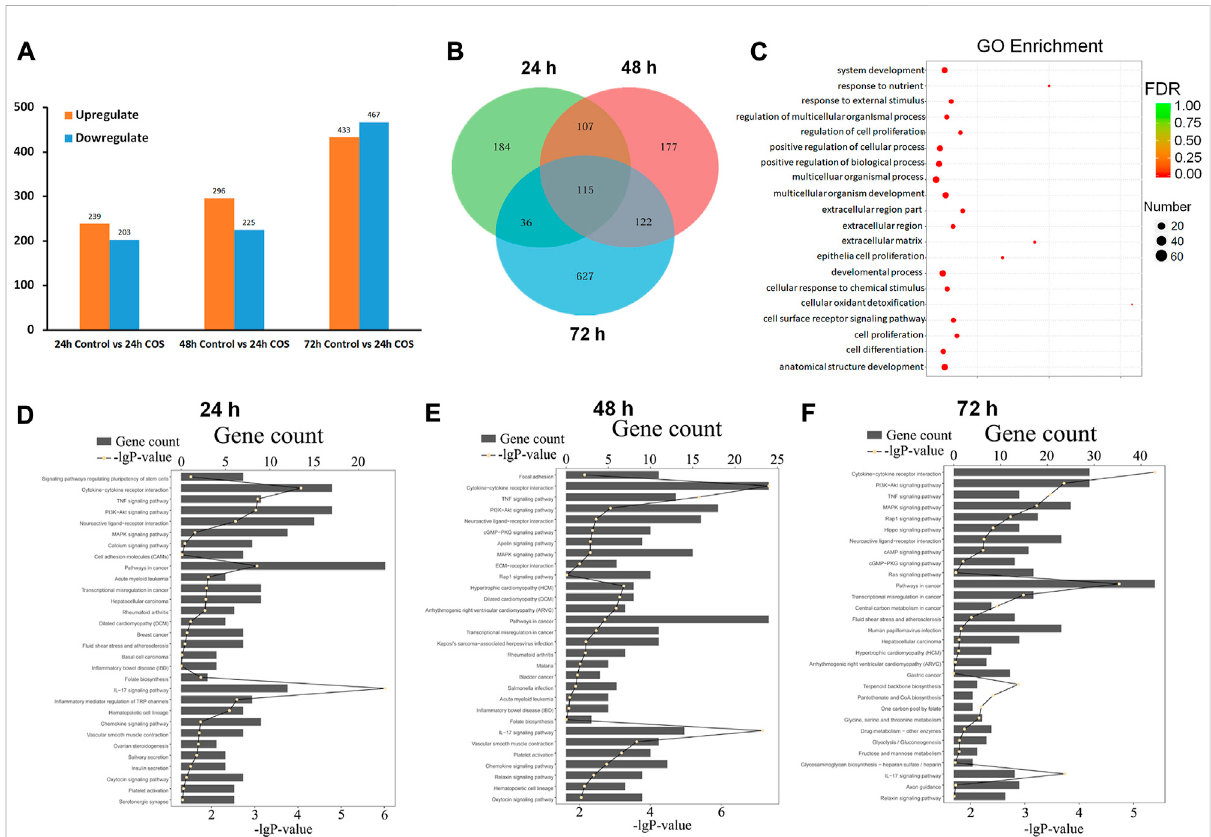
FIGURE 7 Functional annotations of gens in the COS-treated fi broblasts (A) Upregulated and down-regulated genes at each time point. (B) The Venn diagram of DEGs (C) GO analyses showed 20 signi fi cant functional annotations reveals by the target genes. (D – F) KEGG analyses showed the most signi fi cantly enriched canonical signaling pathways at different time points. The total number of genes is showed in each pathway, and the yellow dots for each pathway indicates − log ( p